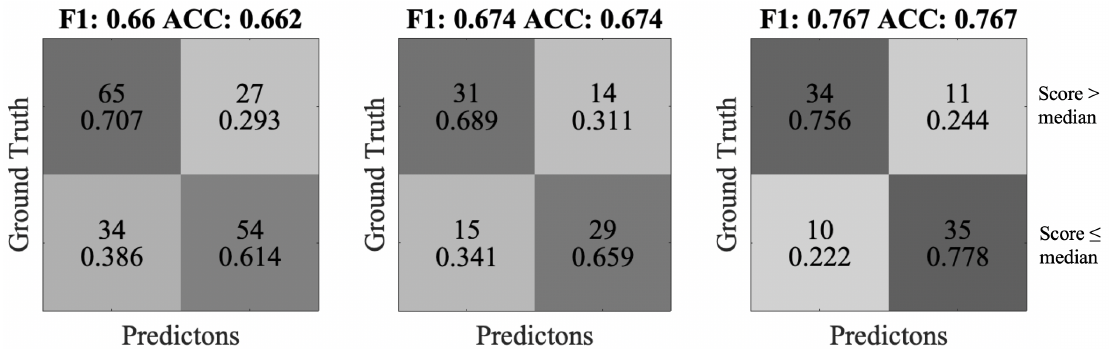
Figure 15. The confusion matrices of identifying whether the session score is above or below average. From left to right: all, 10 least expressive and 10 most expressive